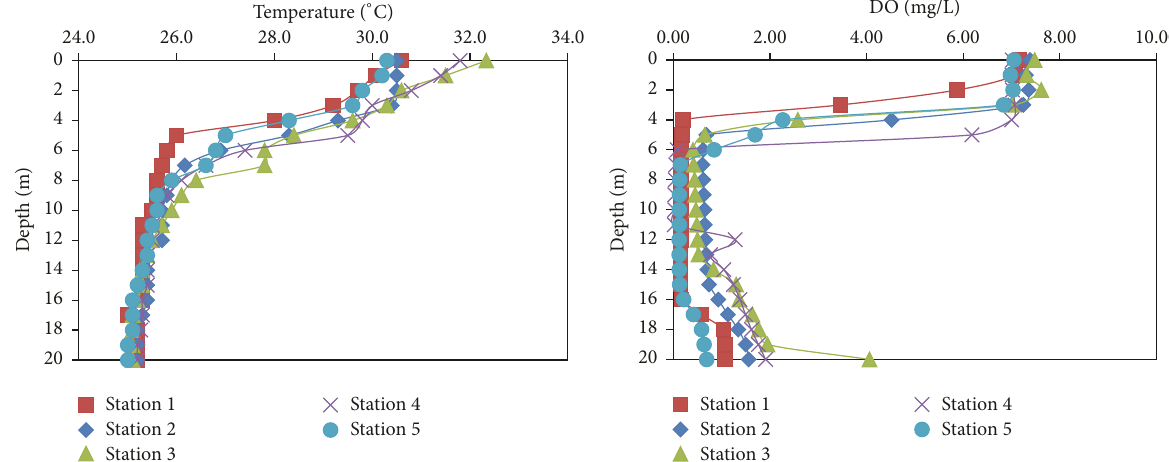
Figure 2: Depth profile of temperature and DO in Bakun Reservoir in February